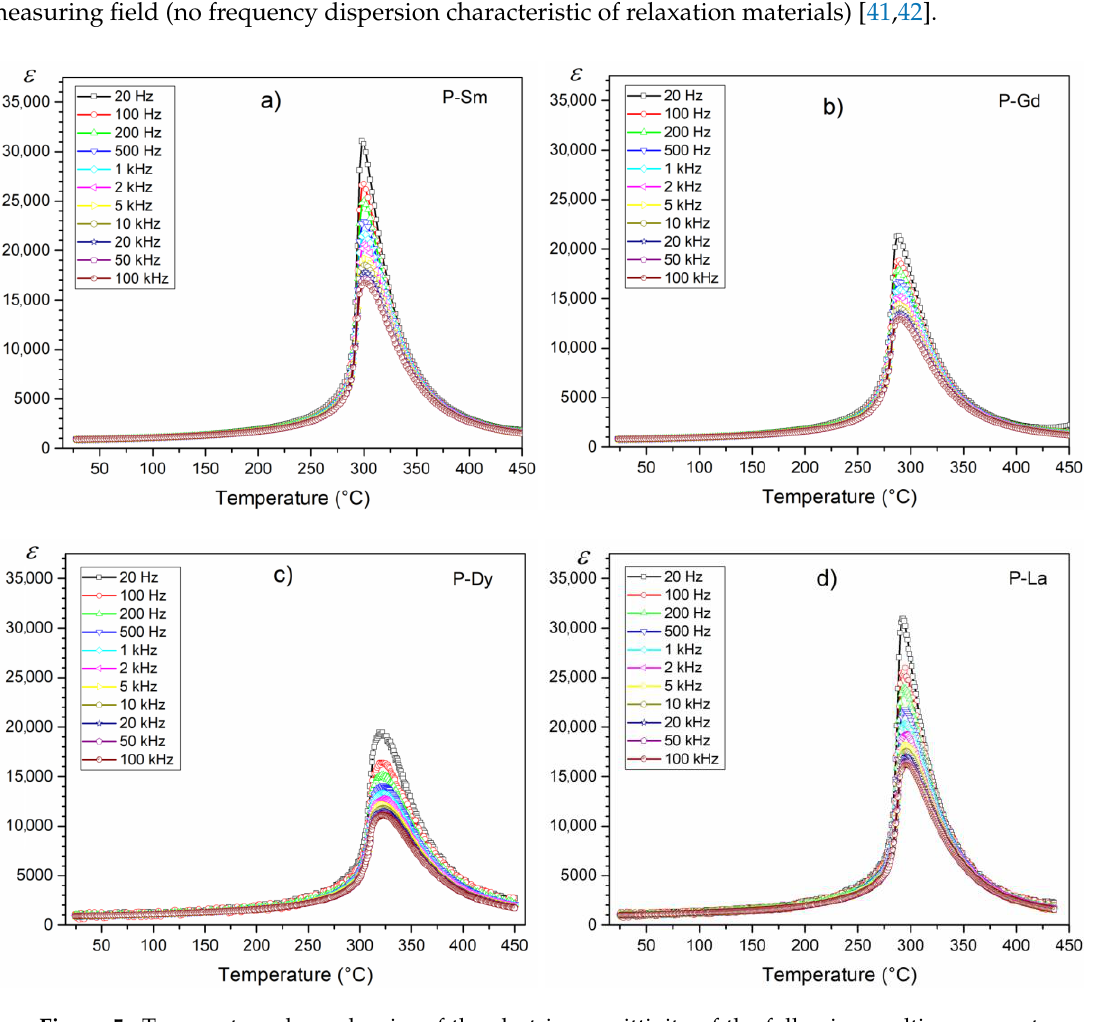
Figure 5. Temperature dependencies of the electric permittivity of the following multicomponent PZT-type samples: ( a ) P-Sm, ( b ) P-Gd, ( c ) P-Dy, ( d ) P-La.